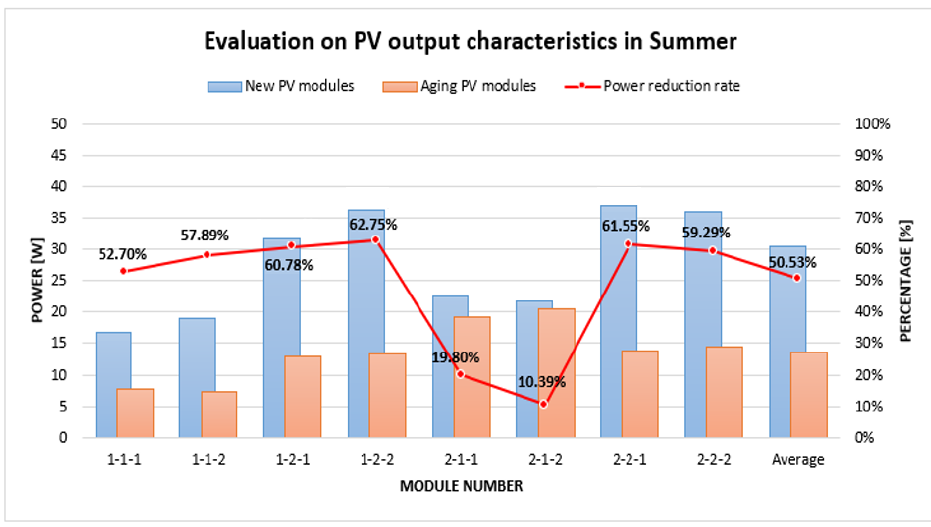
Figure 8. Output characteristics between new and aged PV modules in summer.